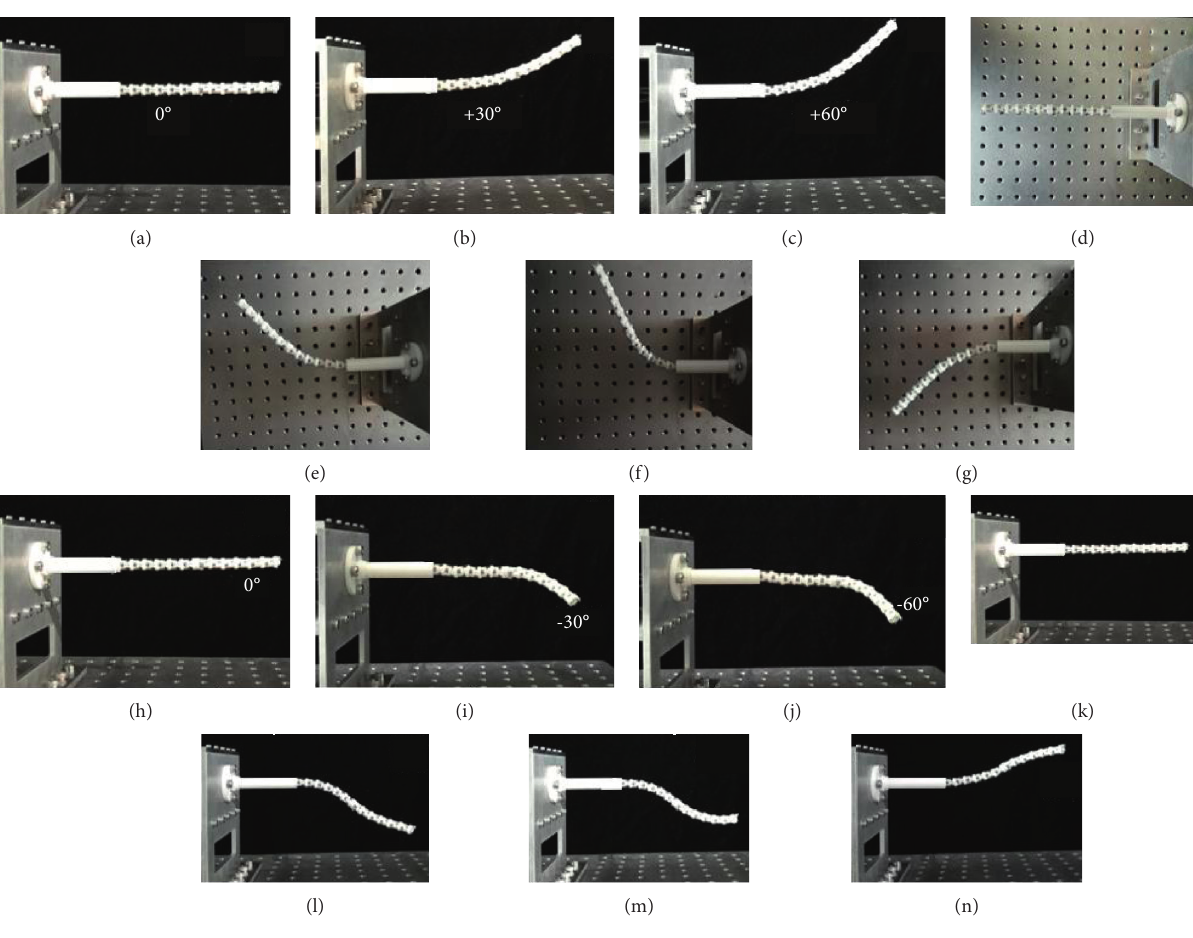
Figure 14: Robot bending motion